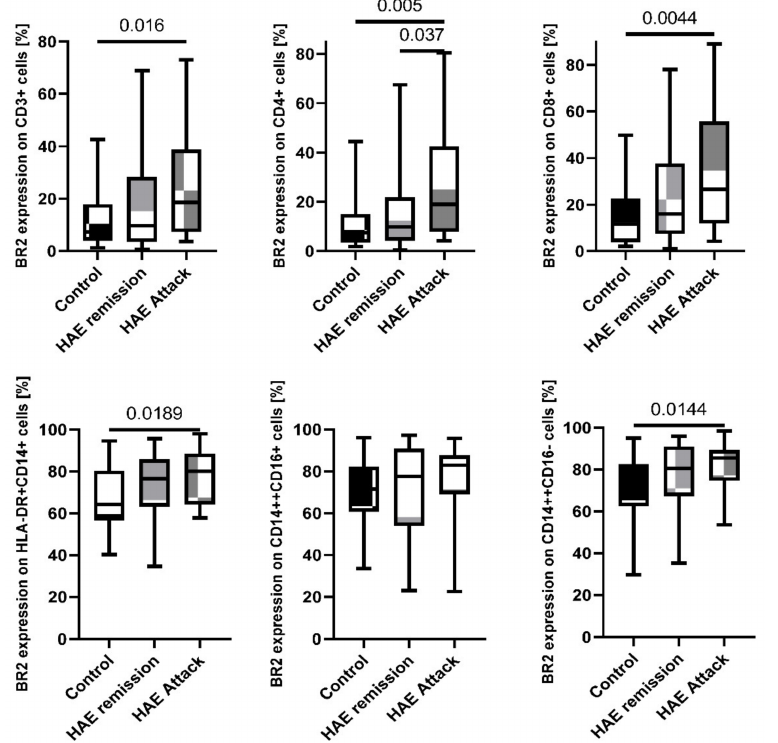
Figure 4. BR2 expression on subpopulations of lymphocytes and monocytes among HAE patients during attack and in the remission compared to the healthy control subjects.